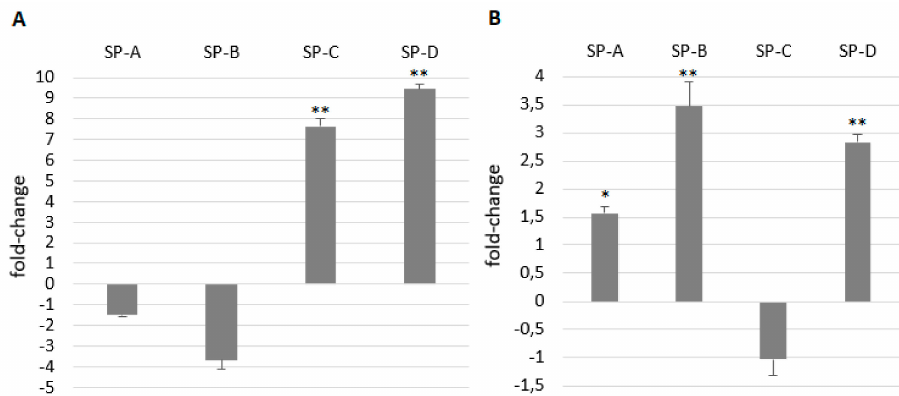
Figure 7. Comparison of SPs’ gene expression in short and long-term cultures of A549 cells ( A ) and the e ff ect of LPS on SP gene expression after 24-h treatment with LPS in long-term A549 cells ( B ). On graph A, SP gene expression in short-term cells represents basal (zero) line. Compared to short-term cultures, gene expression of SP-C and SP-D was much higher in long-term cultures of A549 cells ( A ). On graph B, SP gene expression in untreated long-term cells represents the basal (zero) line. SP gene expression in long-term cultivated cells was enhanced by LPS ( B ). Data are presented as means ± SDs from